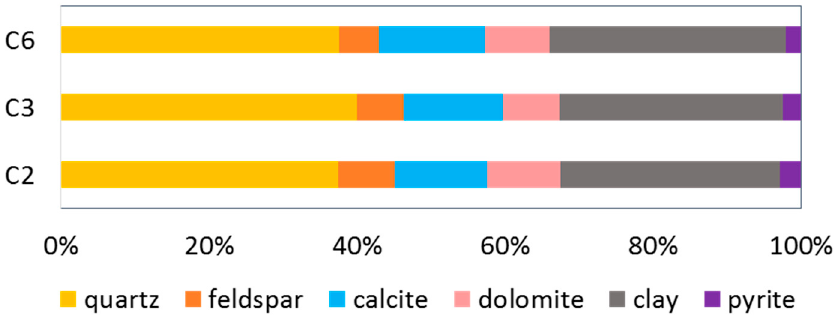
Figure 4. Mineral composition and average content of shale at different depths in the upper part of Es3 in well F39x1.